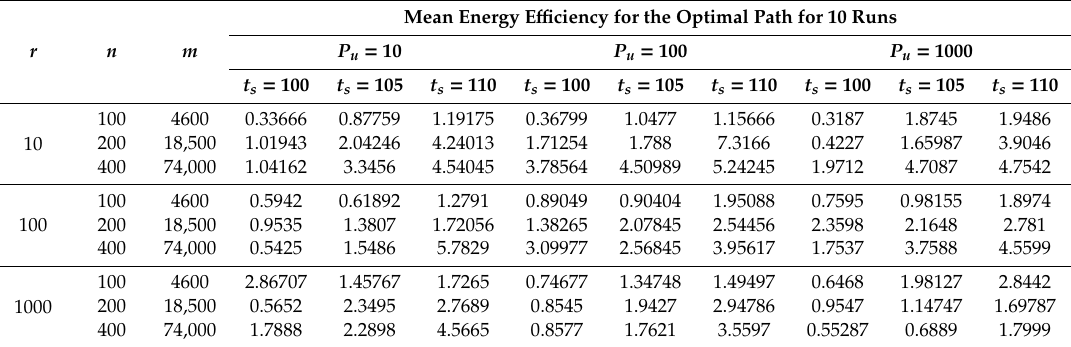
Table 7. Mean energy e ffi ciency for the e ff ective path for the SESE algorithm for 10 Mb .